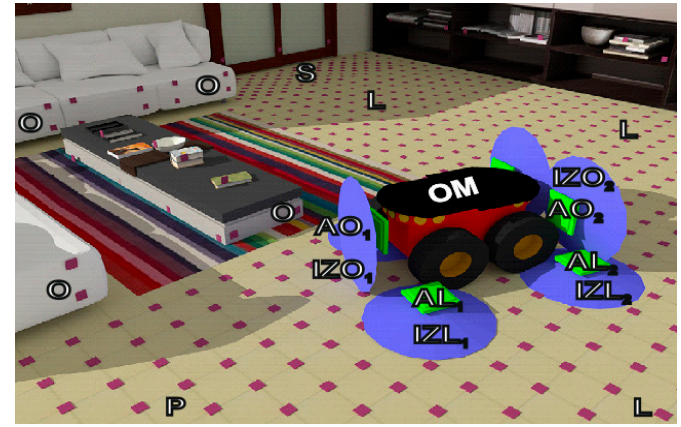
Figure 29. Idea of intelligent navigation system. P—navigation network; L—area with standard point density; S—area with changed density of points; O—marked obstacles; OM—mobile object; AL n —RWD antenna; IZL n —interrogation zone.